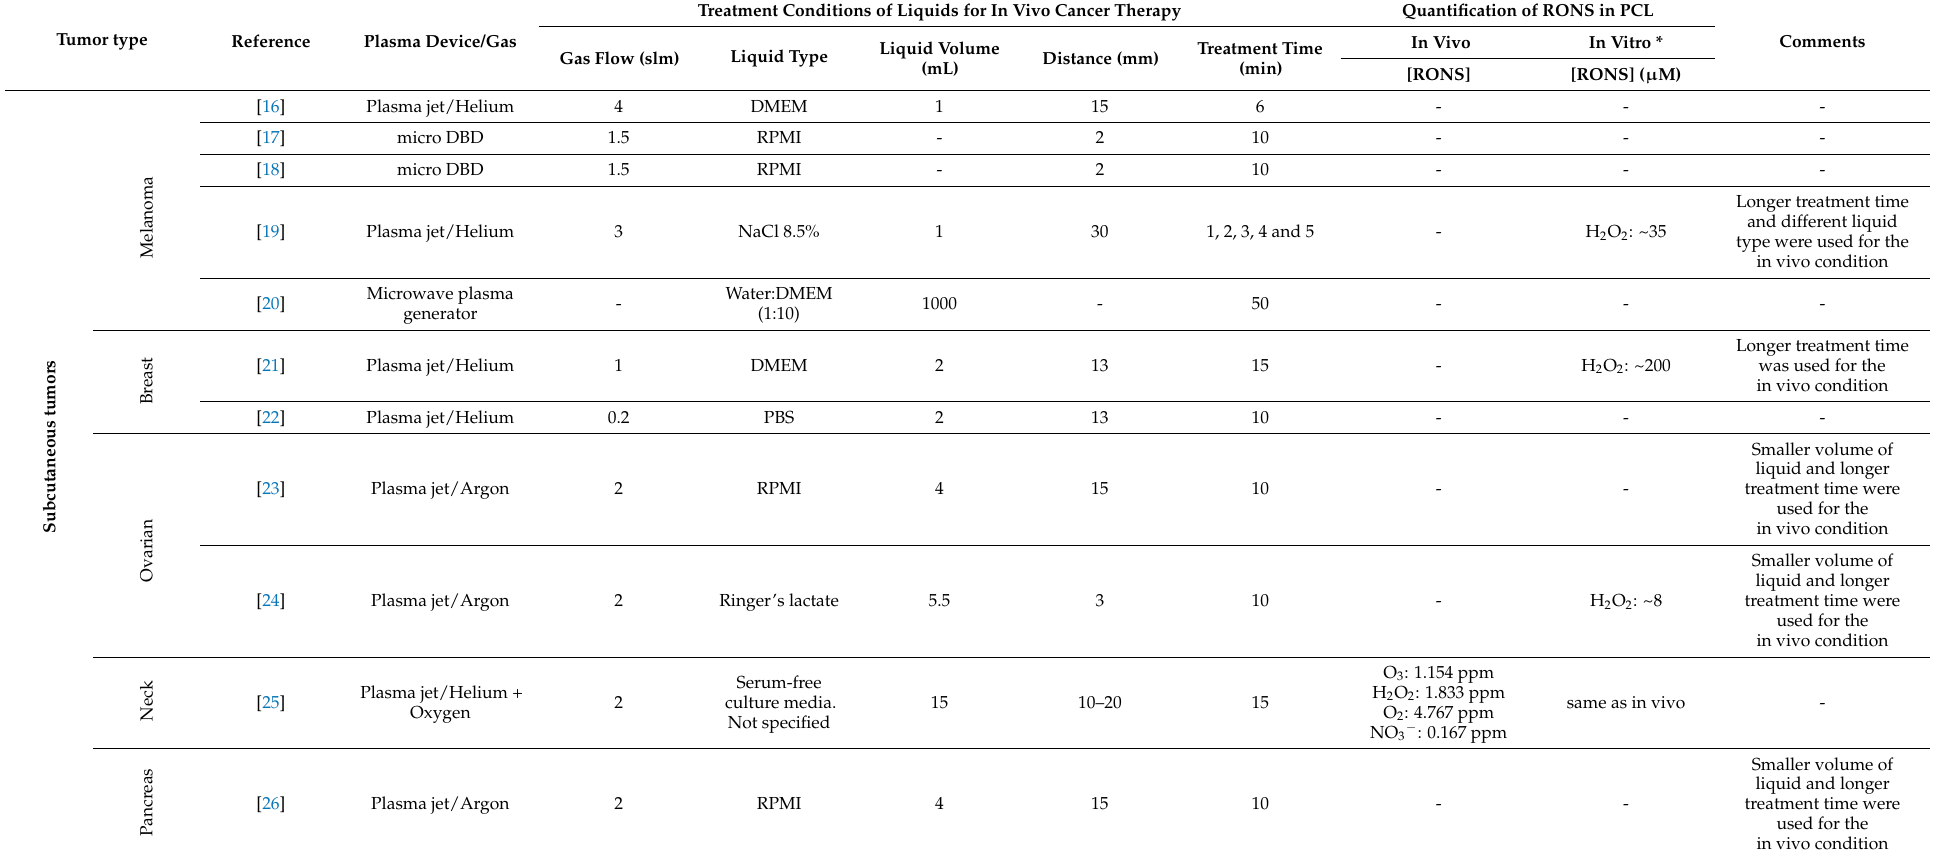
Table 1. Cold atmospheric plasma settings employed for the generation of PCL for in vivo cancer treatment. Comparison between the concentration of RONS employed in in vivo studies and in their associated in vitro